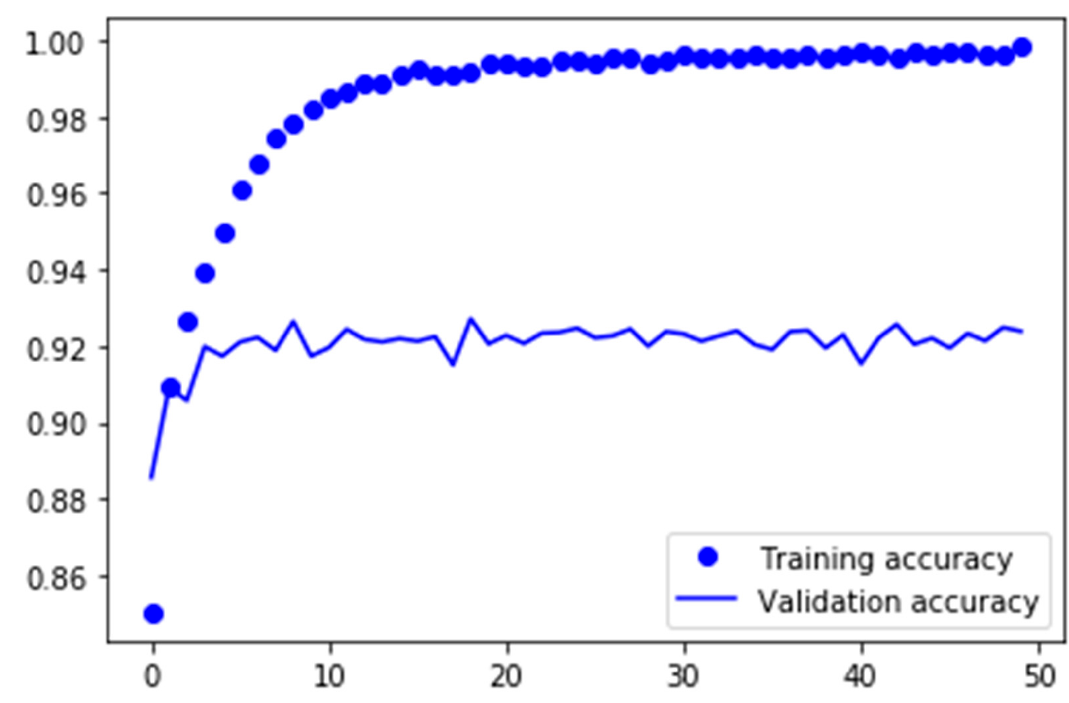
Figure 10. Training and validation accuracy of model 1.11 without dropout layers. In Figure 11, the same model trained with dropout layers is plotted, and the difference is quite clear to see. The gap between the training and validation accuracy almost vanished when dropout was applied.